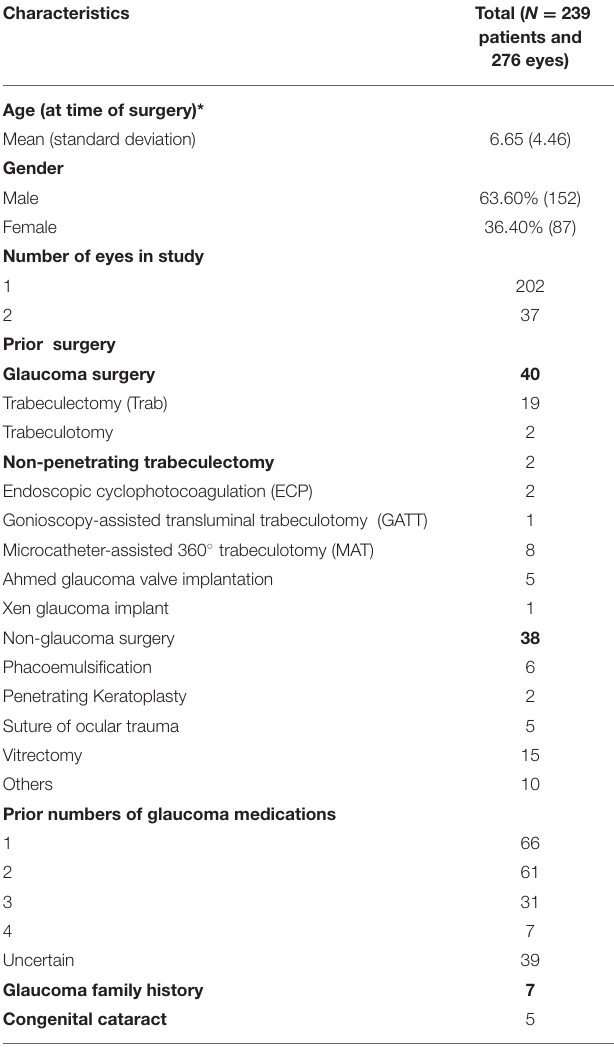
TABLE 1 | Pediatric glaucoma patient and ocular